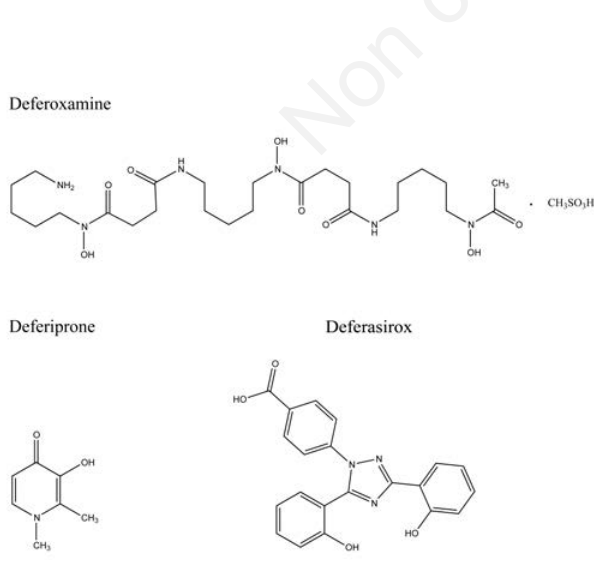
Figure 1. Formulas of the three iron chelating agents currently in use.